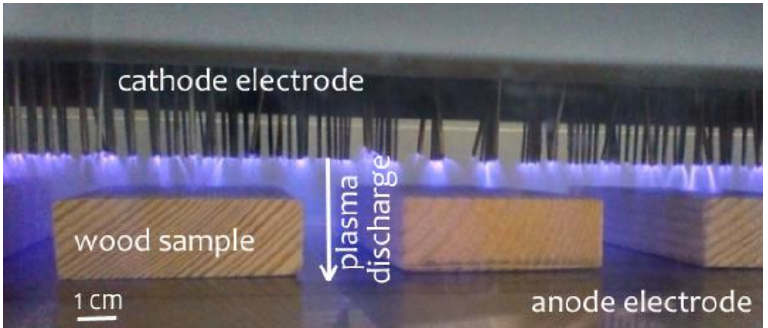
Figure 1. Plasma modification of the top surfaces of spruce samples in the “Atmospheric Discharge with Runway Electrons” (ADRE)